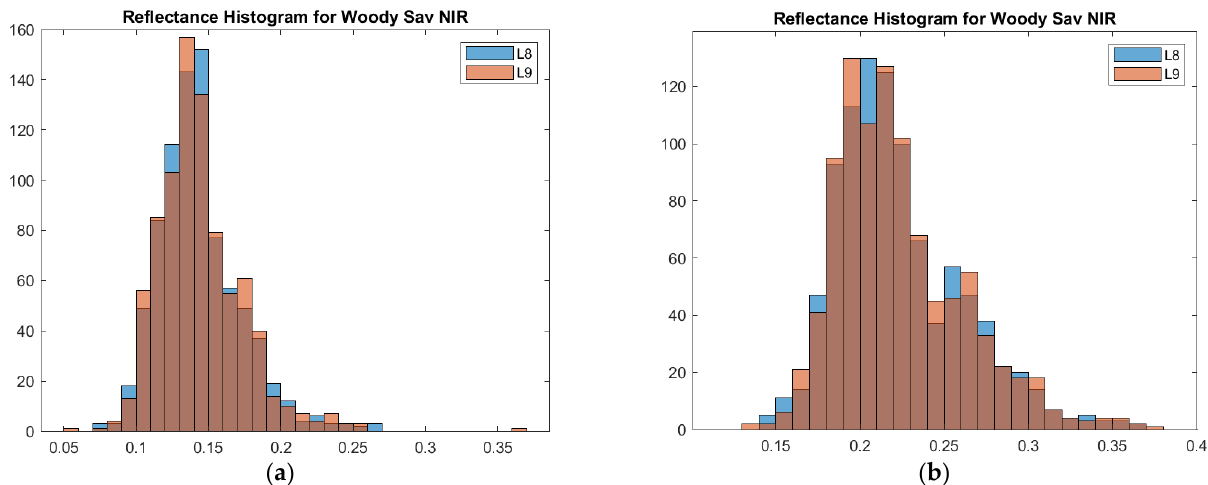
Figure 5. ( a ) Woody Savanna global NIR band reflectance distribution. This plot corresponds to reflectances above the Tropic of Cancer latitude. ( b ) This plot corresponds to reflectances below Tropic of Cancer. Note the peaks split up after separating by latitude.